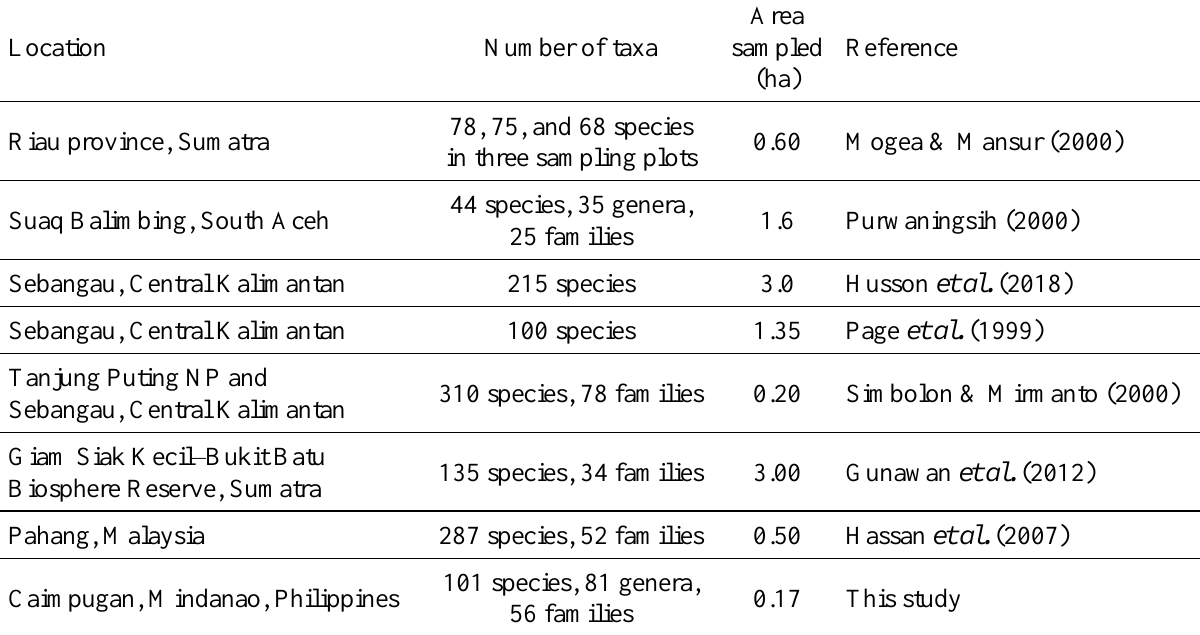
Table 2. Comparison of the diversity of trees and other vascular plants reported from peat swamp forests in Southeast Asia. All except the last two sites listed are in Indonesia. NP = National